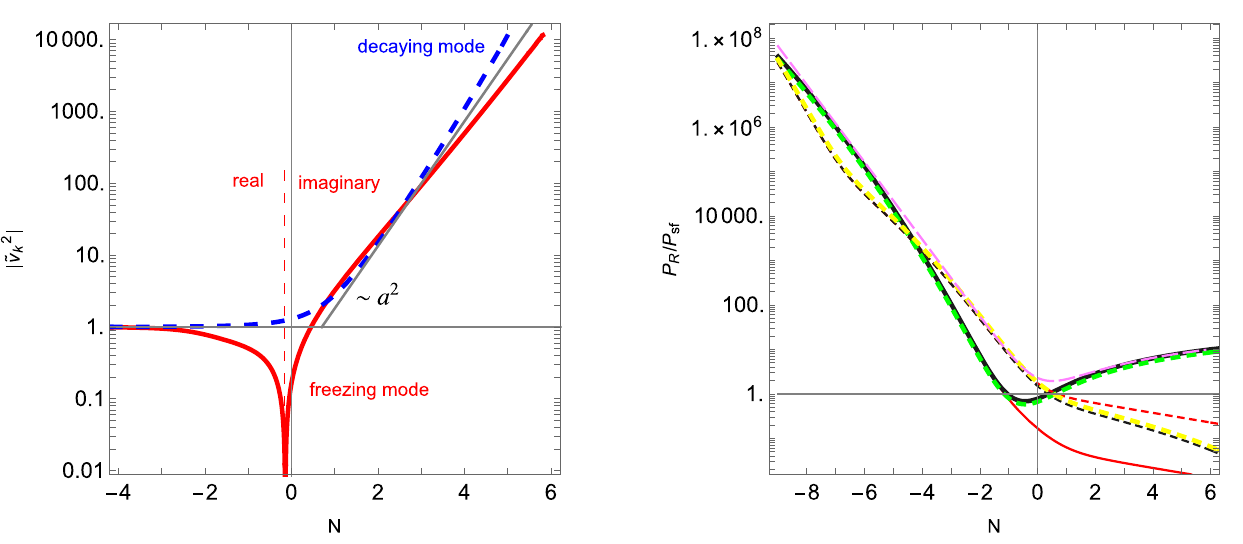
speed, is indicated; thin dashed line corresponds to the value (22). Right panel: evolution of the instantaneous power spectra in the full theory and in the effective theory; color coding described in Table 1; N = 0 corresponds to the Hubble radius crossing; the pink line corresponds to the total curvature power